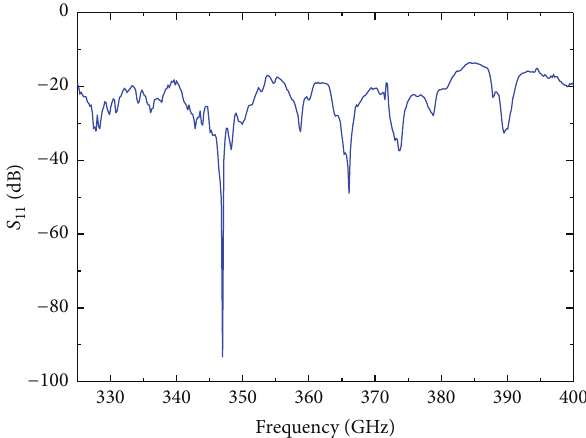
Figure 6: The measured return loss of the THz absorbing material.